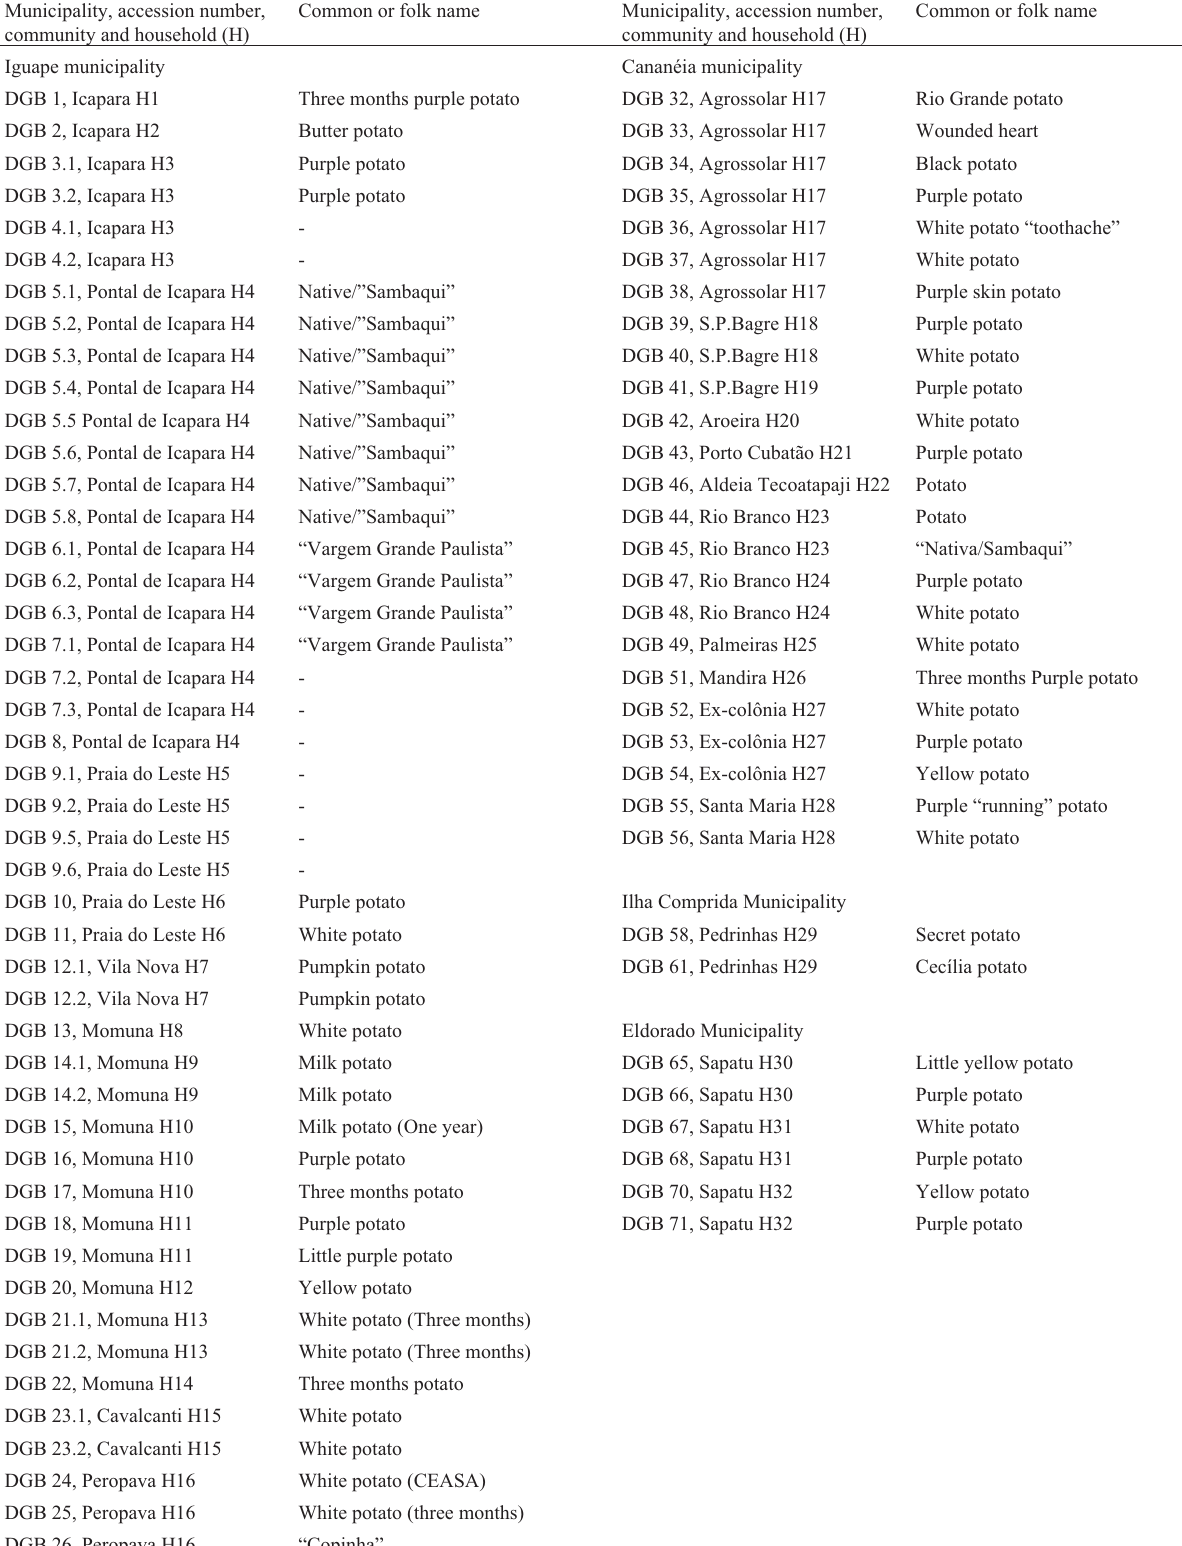
Table 1 - Origin, accession number and common or local names, and identification of 78 sweet potato ( Ipomoea batatas ) accessions (landraces and clones) collected in the Vale do Ribeira, Sao Paulo, Brazil. Accessions with a decimal ( e.g. , 3.1 and 3.2) represent replicate material from different vines or tubers of the same landrace and can be considered as putative clones. A dash (-) indicates that no name was given by the farmer. Municipality, accession number, community and household